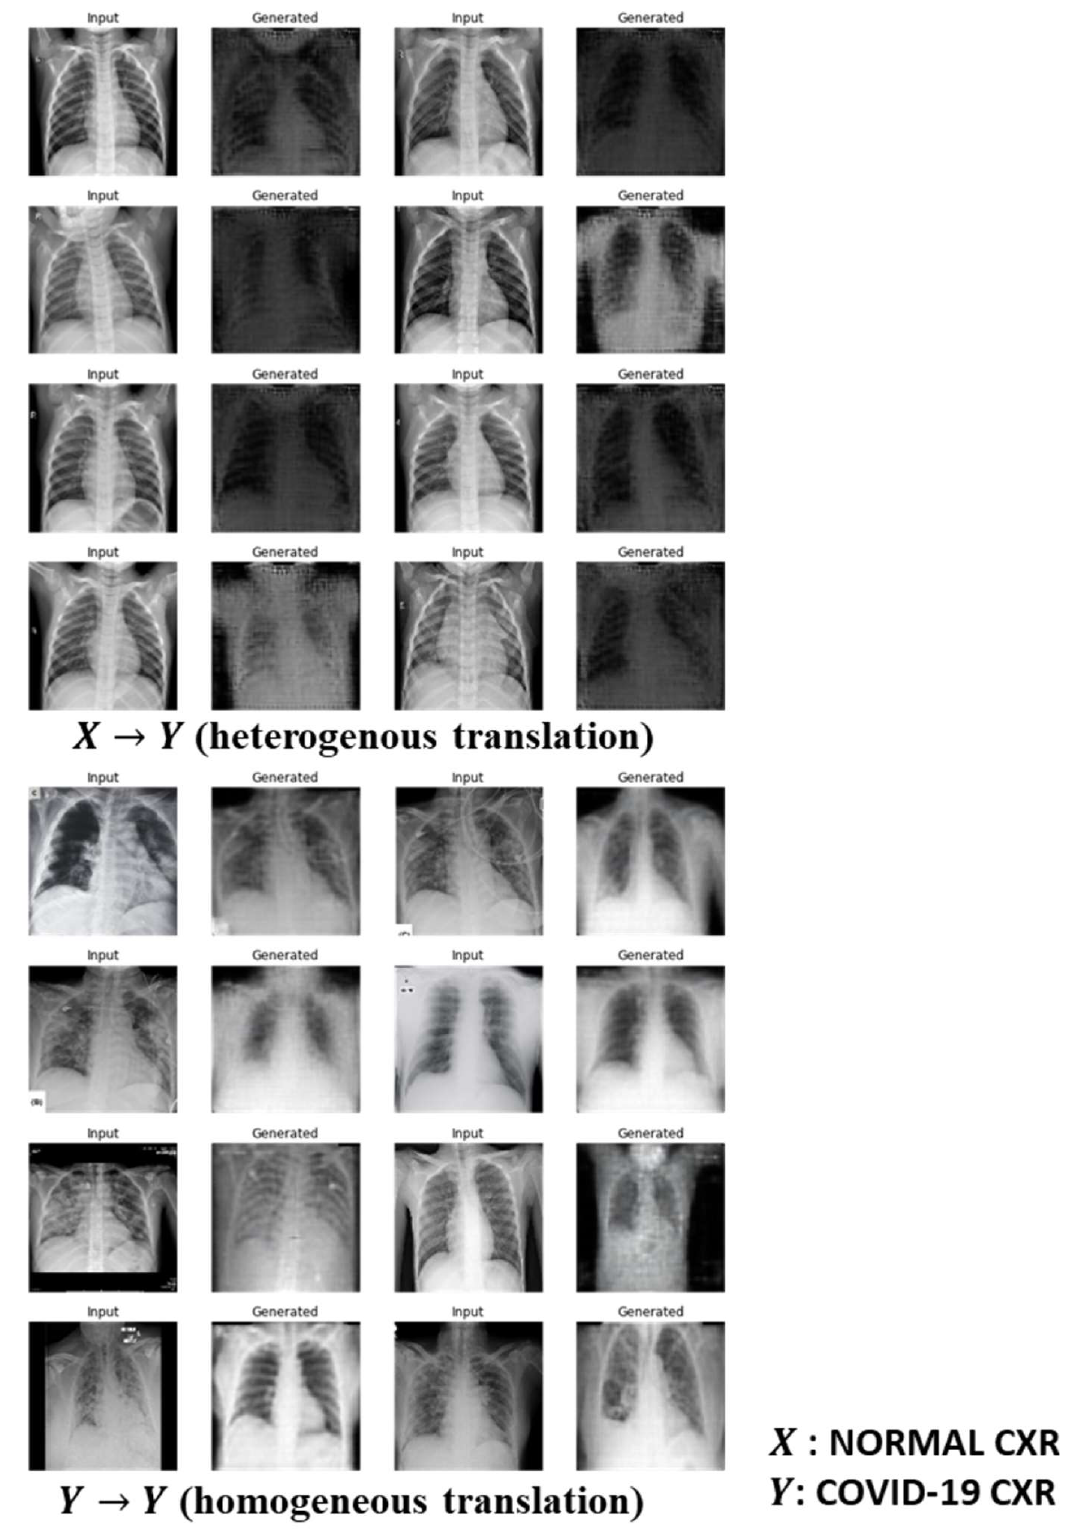
Figure 4. Image translation by Ad CycleGAN.